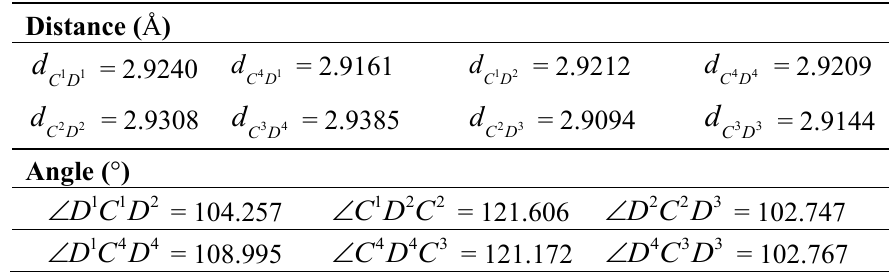
Table 2. The distances between dummy atoms and bridging carbons and three pairs of angles in the geometrical helix model of (−)- 1